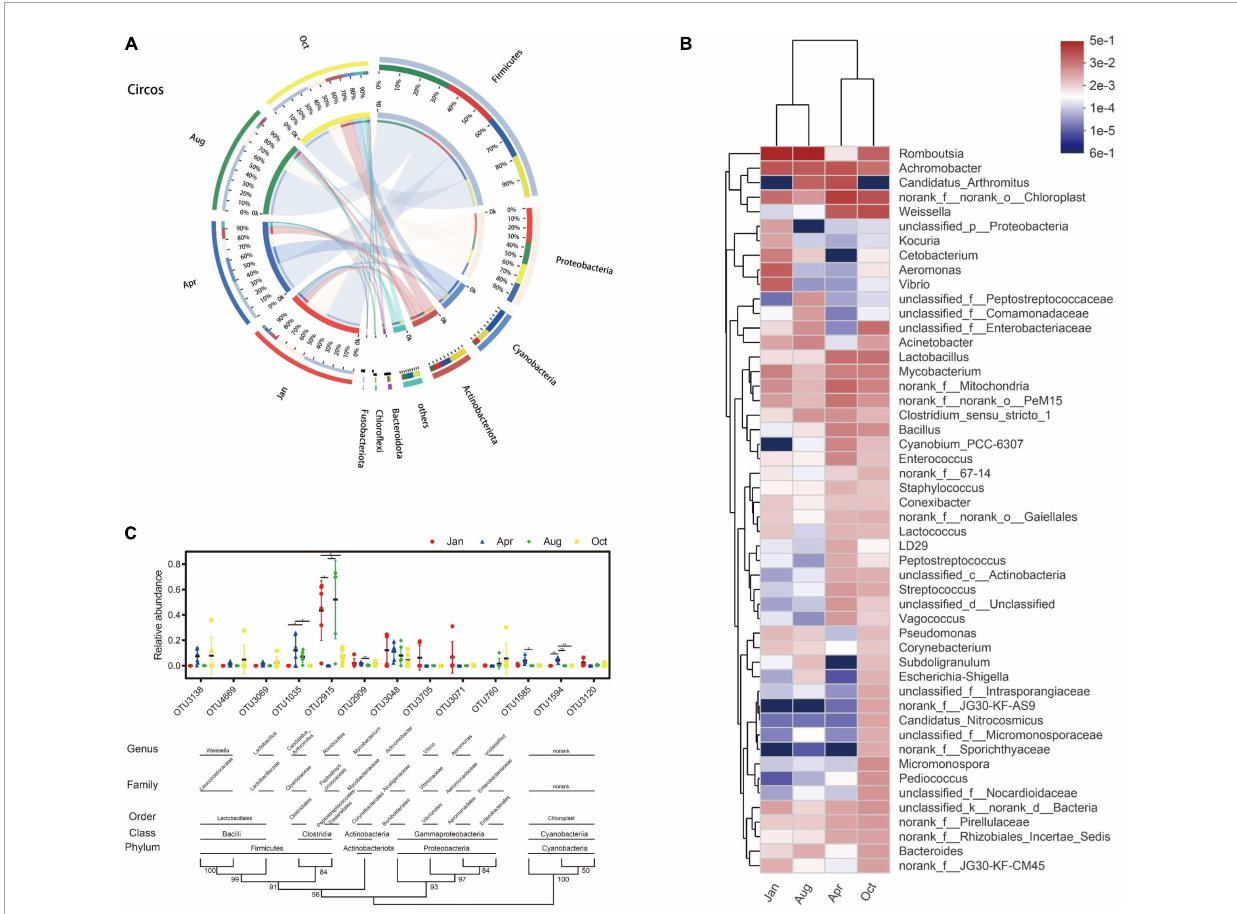
FIGURE3 Composition and dynamic changes of gut microbes. (A) Collinear relation diagram between bacteria phylum and each group. Only phyla with an average abundance greater than 1% are presented, and the rest are merged into others. (B) Heatmap of bacterial genus level in each group. Only the top 50 abundance bacterial genera are shown in the figure. Bacterial genera and groups were clustered using the average algorithm. The color of the color blocks was used to indicate the relative abundance of each genus. (C) Classification and change of main OUT in each group. Only OUT with mean abundances greater than 1% are shown in the figure. OUT presented in the figure is clustered using the N-J algorithm. The values of the cluster tree represent the degree of reliability of this branch. Above the cluster tree are species classifications corresponding to OUT. Scatter plots were used to represent the abundance of OUT and mean ± standard error were presented. ∗ p < 0.05, ∗∗ p <